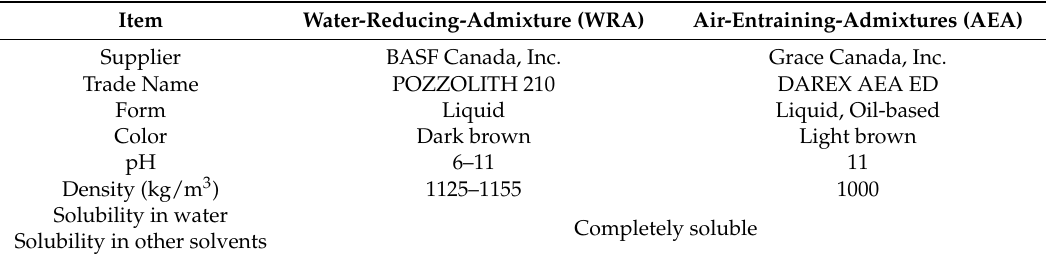
Table 3. Summary of admixture properties.